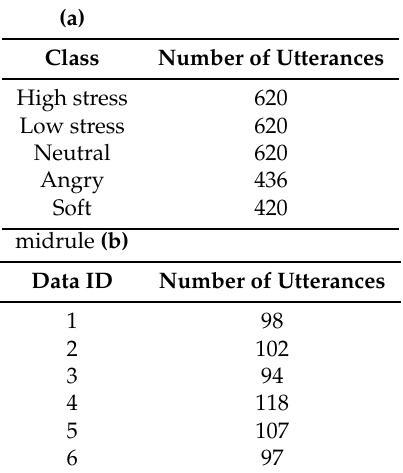
Table 2. The dataset used in the experiments. ( a ) is the data used for development and enrollment phase while ( b ) is the data used for verification